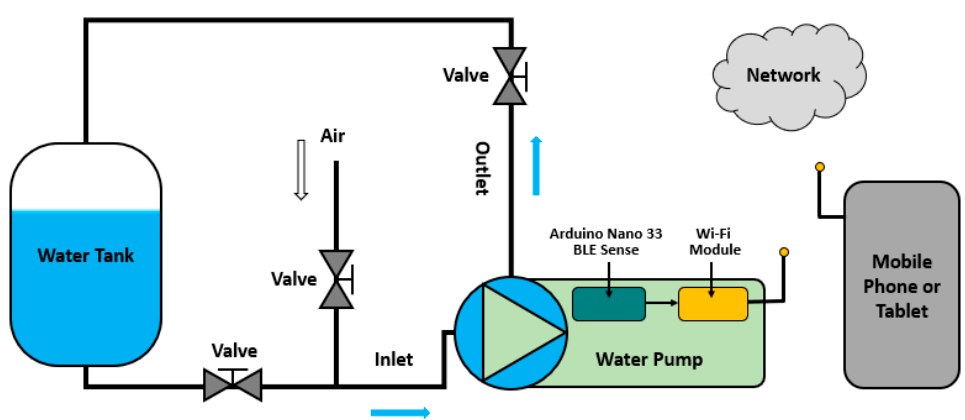
Figure 2. A functionality overview of the proposed water pump malfunction detection system.